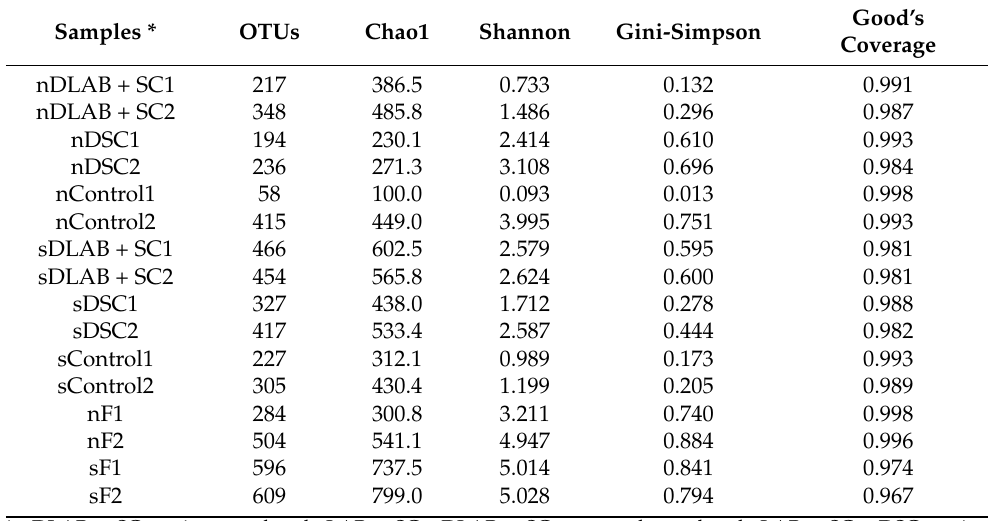
Good’s Coverage